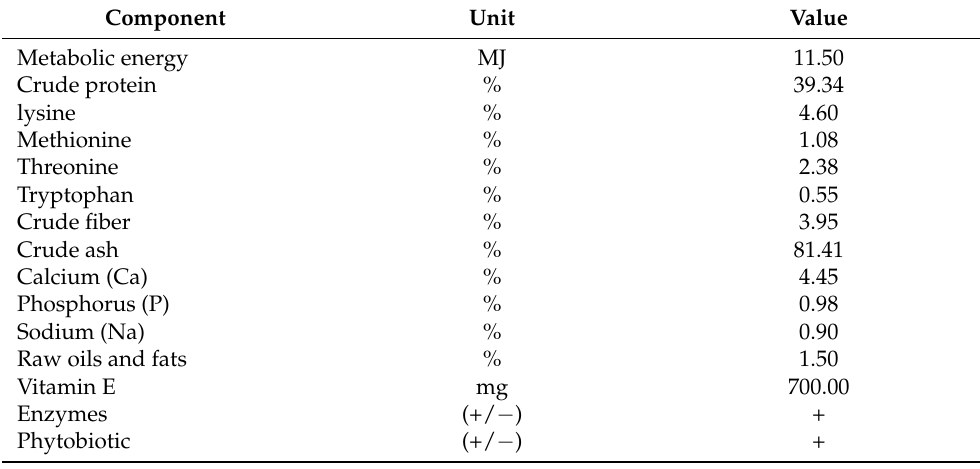
Table 1. Nutrition components of Dan Bred fattening pigs in the form of Superconcentrate 600 plus